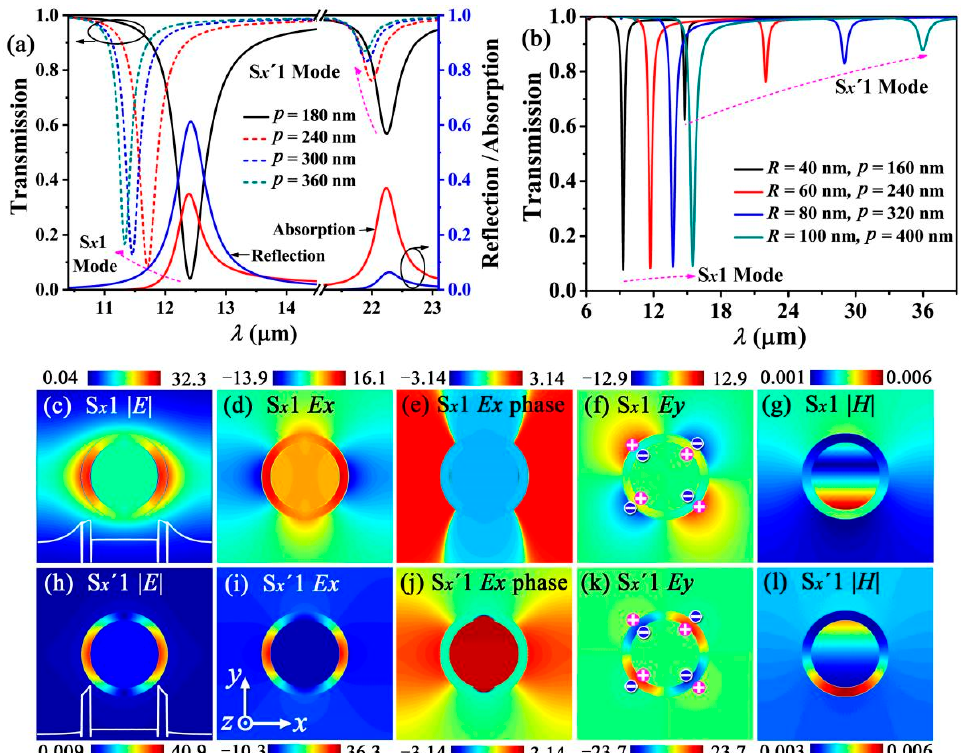
Figure 2. ( a ) Simulated transmission spectra with different periods of waveguide array p for a fixed waveguide radius R = 60 nm. The blue solid line and the red solid line represent the reflection spectra and absorption spectra as p = 180 nm, respectively. ( b ) Simulated transmission spectra with different waveguide radius R and period of waveguide array p following the relation p = 4 R . ( c – g ) show the | E |, E x , E x phase, E y , and | H | distribution of the S x 1 mode on the cross-section of the waveguide, respectively. ( h – l ) show the | E |, E x , E x phase, E y , and | H | distribution of the S x ′ 1 mode on the cross-section of the waveguide, respectively. The white lines in ( c , h ) describe the | E| distribution of the S x 1 and S x ′ 1 modes along the x -axis of the waveguide, respectively. The “+” and “ − ” symbols in ( f , k ) represent the positive and negative charges, respectively. This charge distribution is obtained from the EM field boundary conditions of (cid:42) (cid:42) (cid:42) n · ( D 2 − D 1 ) = σ